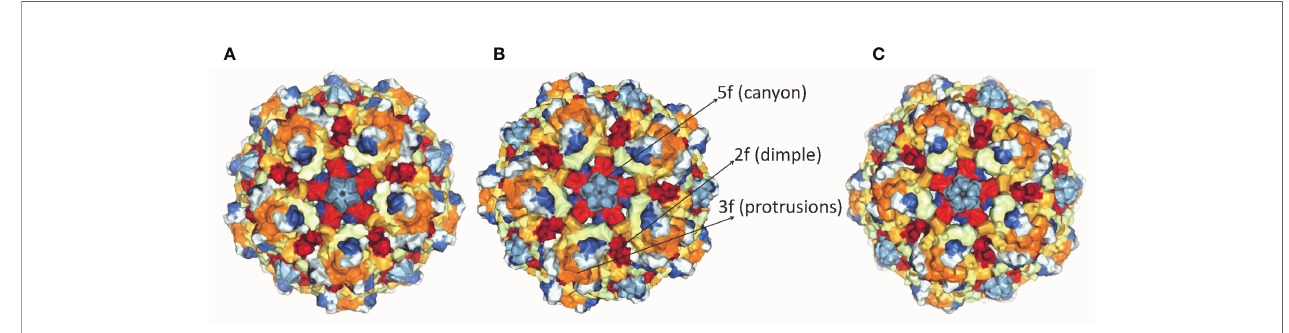
FIGURE 1 | Structure of capsid of (A) H-1 PV, (B) MVM and (C) CPV. The capsids range in size from18 to 26 nm with icosahedral symmetry consisting of two, three, fi ve-fold axes and have variable regions that affect virus-host cell interactions (PDB accession no.4gbt,